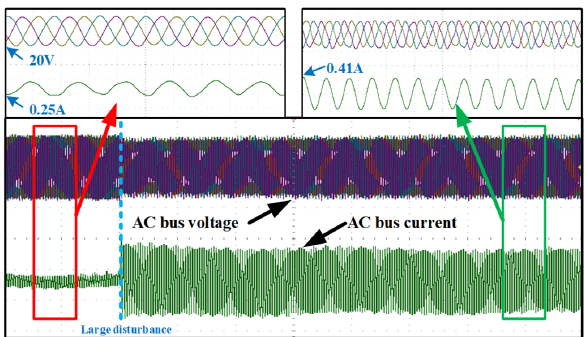
Figure 22. The curves of AC bus voltages and currents in the charging state (Group C).